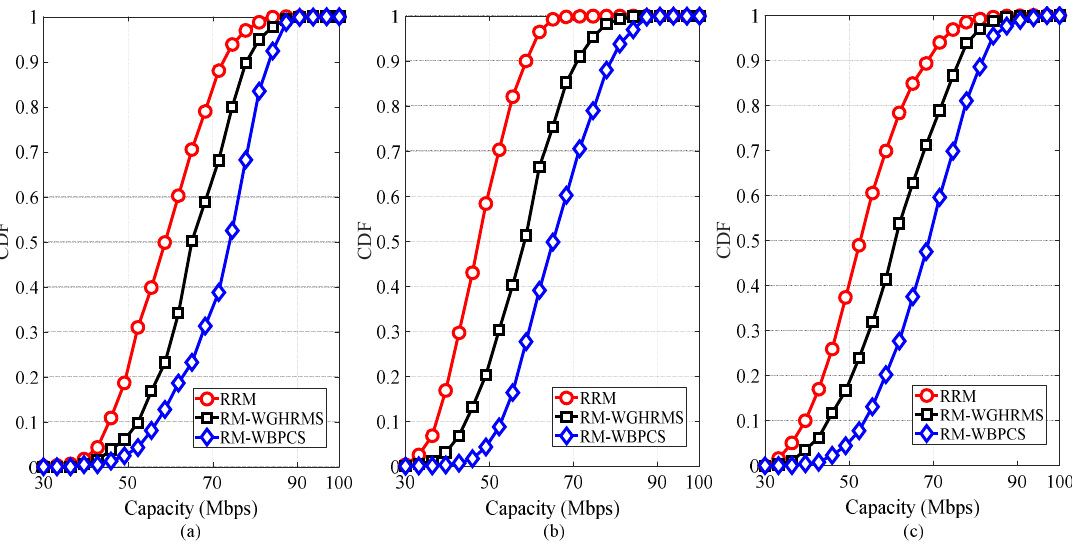
Figure 5. Total achievable capacity for ( a ) DPs, ( b ) CUs, and ( c ) the overall system.